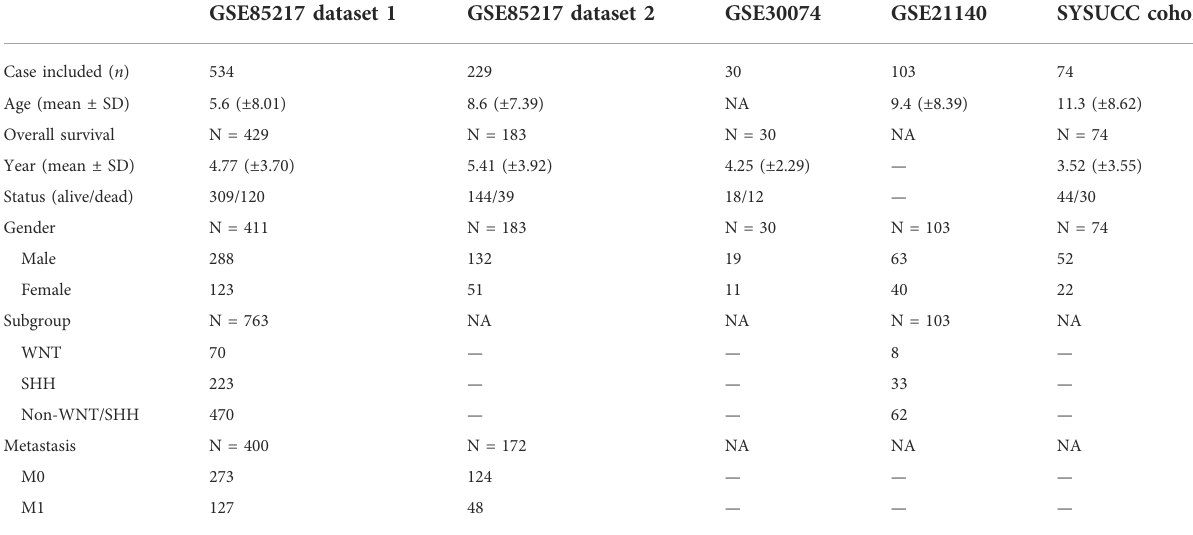
TABLE 1 Summary of clinical information of medulloblastoma